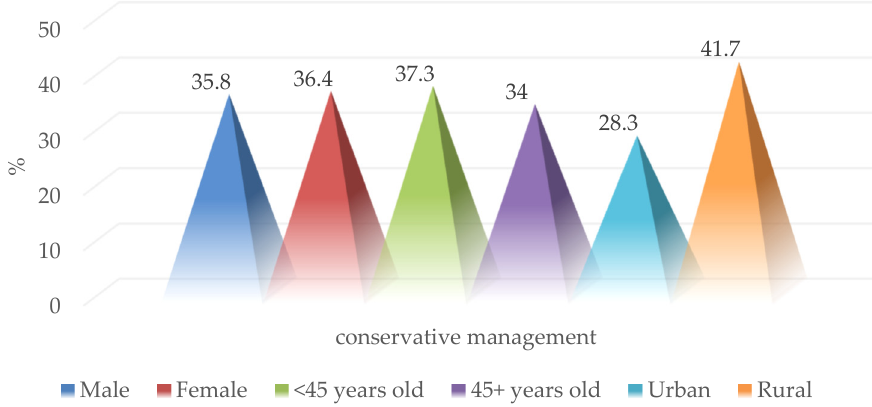
Figure 12. Epidemiological characteristics of patients with conservative management. The conservative therapeutic approach correlated statistically significantly with the self-inflicted mechanism (60% vs. 26.2% and 12.5%; p = 0.001) (Figure 13).